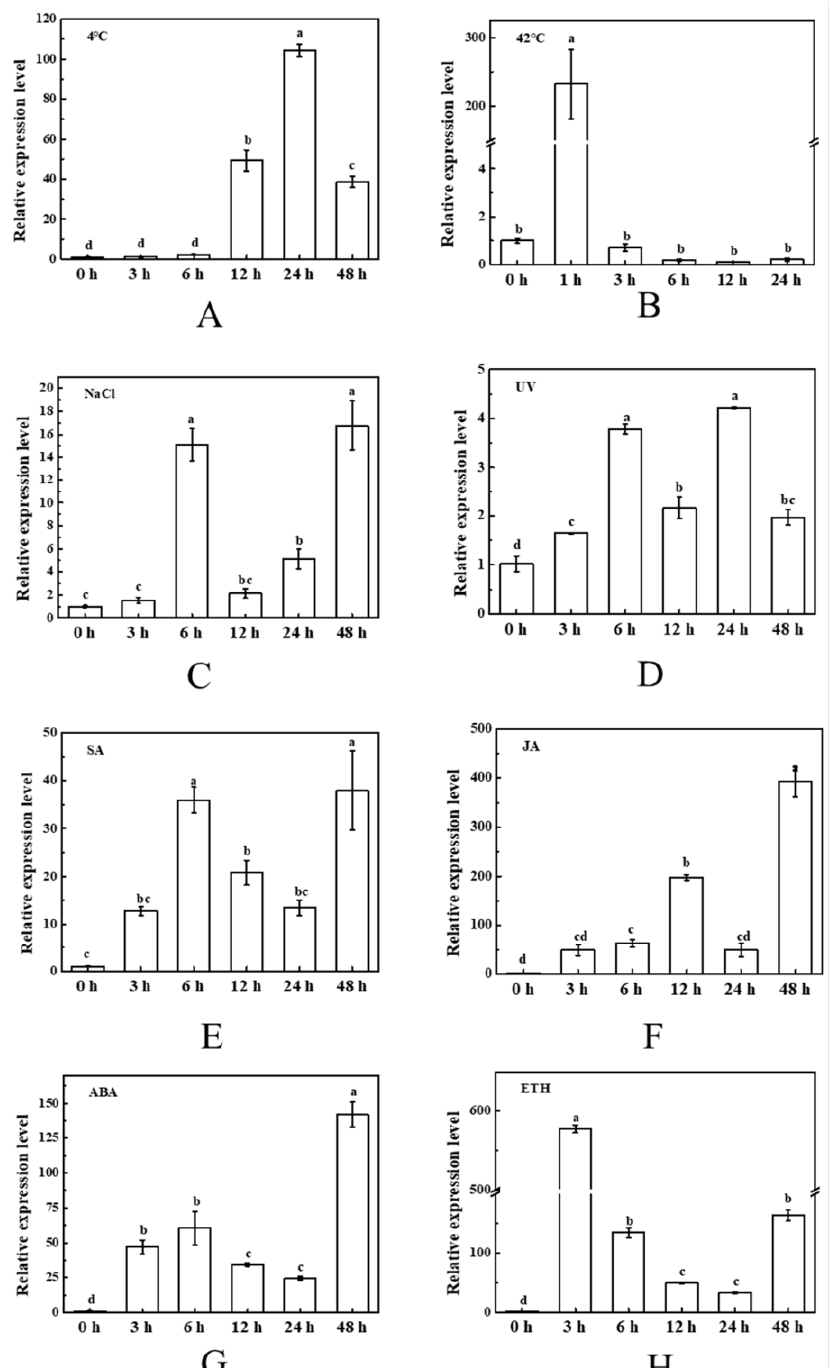
Figure 4. Responses of tomato BAG2 to different abiotic stresses and various hormones. Abiotic stresses: 4 ◦ C ( A ), 42 ◦ C ( B ), NaCl treatment ( C ), and UV irradiation ( D ). Hormone treatments: SA foliage spraying ( E ), JA foliage spraying ( F ), ABA foliage spraying ( G ), and ETH foliage spraying ( H ). Seedling growth conditions set as 14 h/10 h photoperiod with 150 µ mol m − 2 s − 1 light intensity, 23~25 ◦ C/18~20 ◦ C temperature period (except 4 or 42 ◦ C). The young leaf samples were collected at the indicated time points and analyzed by qPCR. For each treatment, the expression level at 0 h was set as 1.0. Different letters indicate expression levels that were significantly different at P <